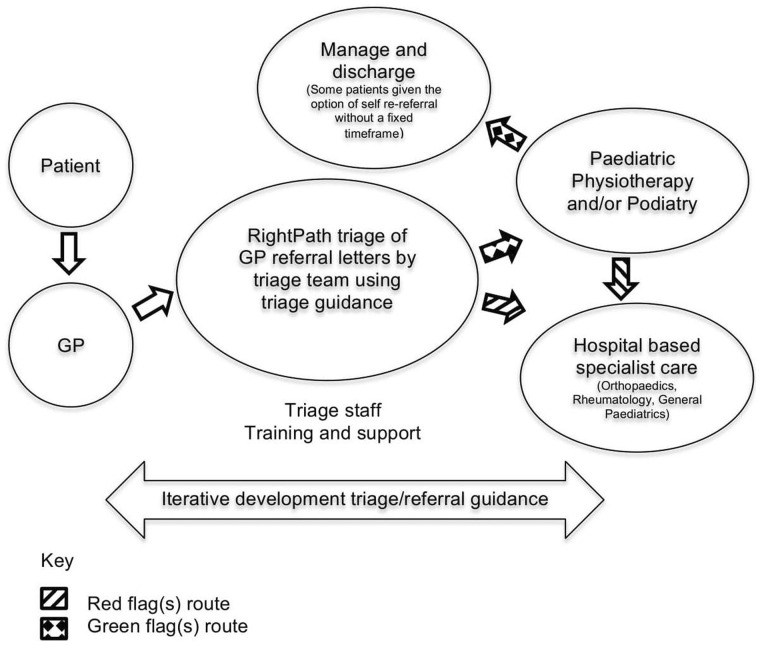
The RightPath modelGP: general practitioner.